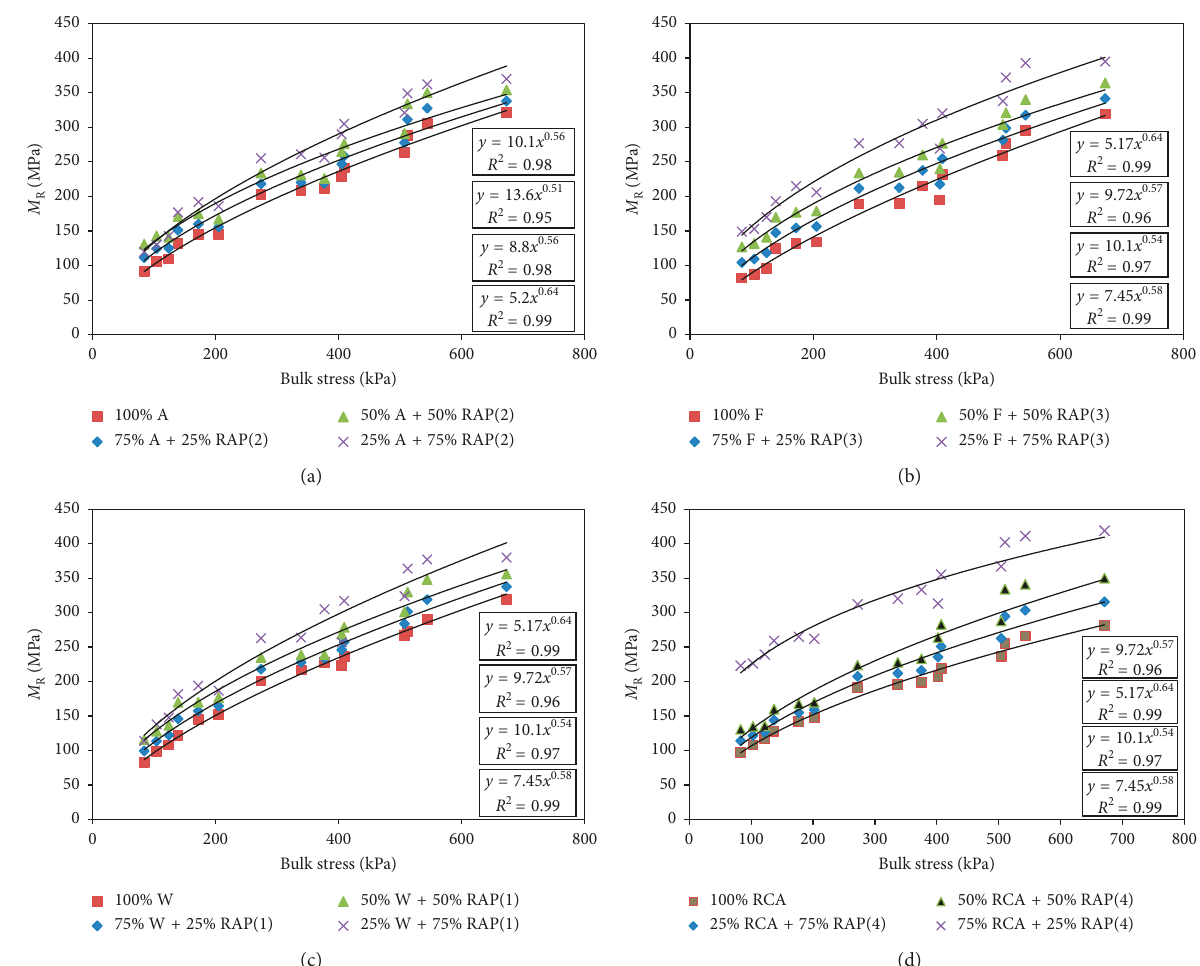
Figure 4: Variation of M R value with bulk stress and percentage of RAP contents for (a) natural A ; (b) natural F ; (c) natural W , and (d) RCA.